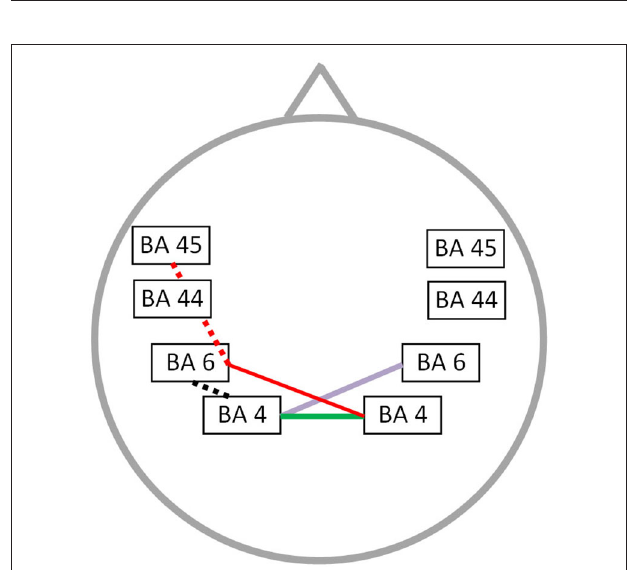
FIGURE 4 | Correlation between neural connectivity and OASES . Positive correlation between neural connectivity and OASES ( p < 0.05) for the delta frequency band (purple line), the alpha 1 and alpha 2 frequency band (green line) and the beta 1 frequency band (red line). A negative correlation was observed for the beta 1 frequency band (red dotted line) and the gamma frequency band (black dotted